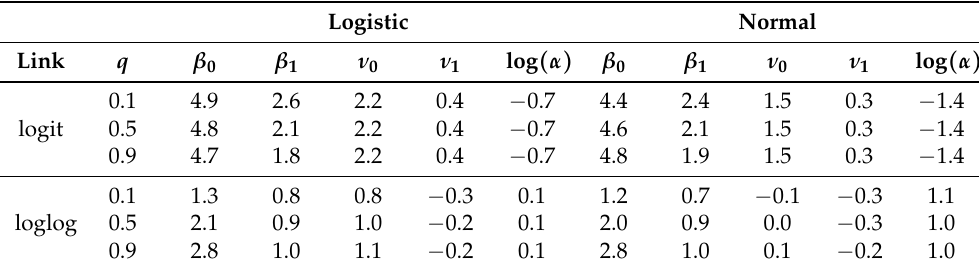
Table 1. True parameters used for simulation studies.